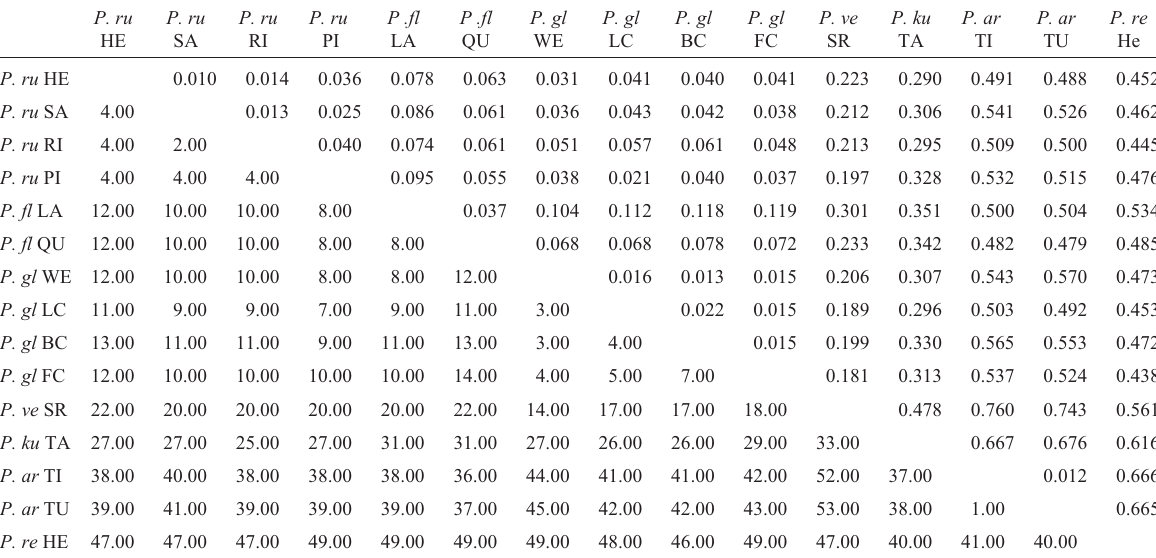
Table 4 - Nei (above diagonal) and Manhattan (below diagonal) genetic distance matrix.